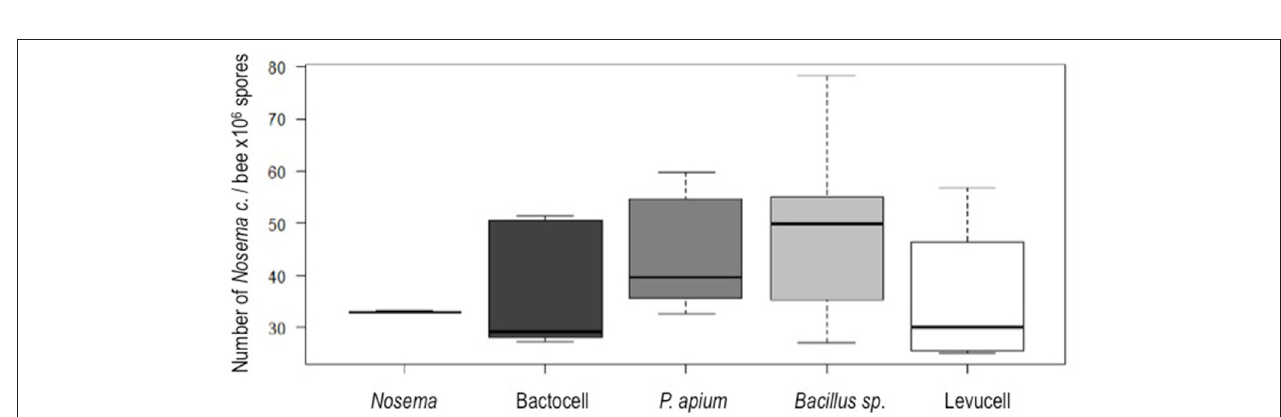
FIGURE 2 | Spore counts per bee in the experimental groups infected with Nosema ceranae. Fifteen bees sampled at day 14 were analyzed (5 bees per experimental group, one cage per experimental group).